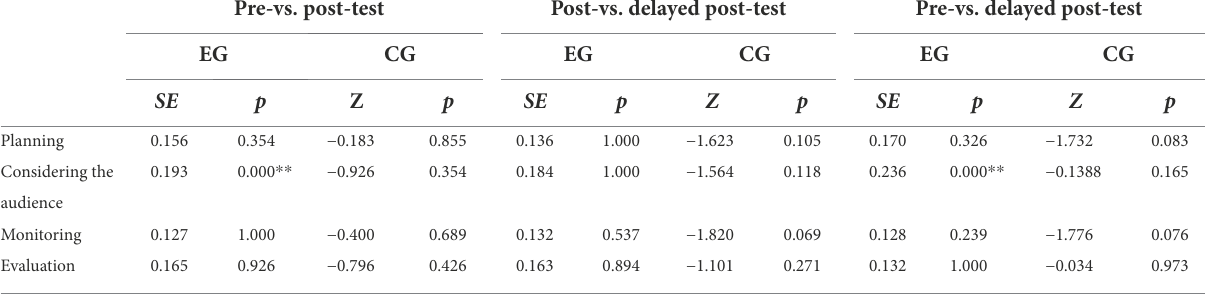
TABLE 3 Effects on metacognitive strategy use for the EG and the